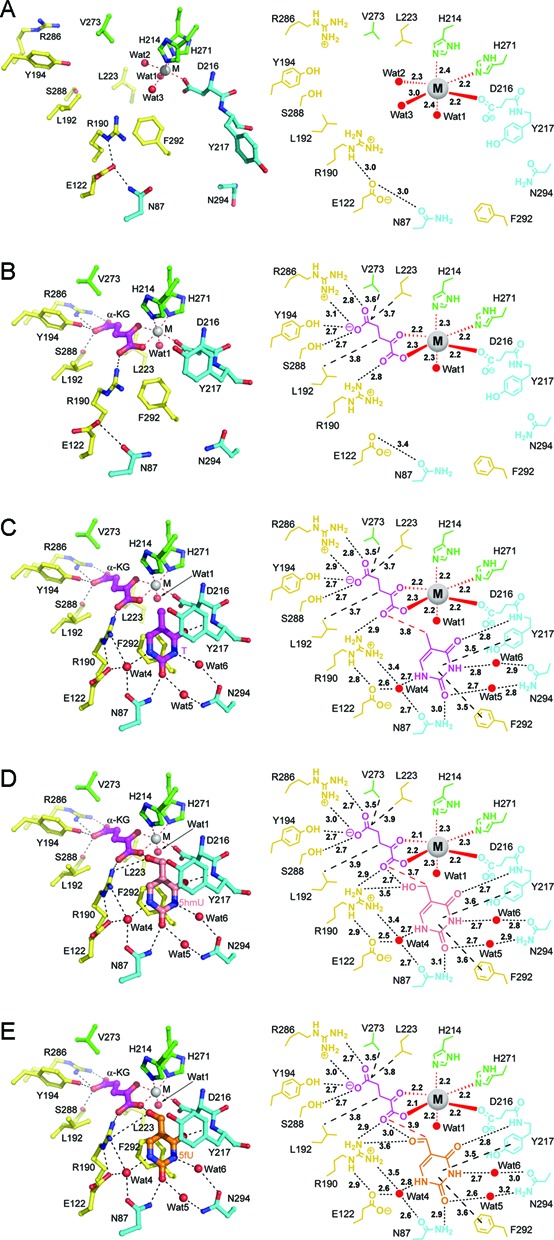
Structure (left panel) and schematic diagram (right panel) of the active site showing the interactions of the metal ion, α-KG and the substrate with the surrounding residues. (A) The apo NcT7HΔC. (B) The NcT7H-AKG complex. (C) The NcT7H-T complex. (D) The NcT7H-5hmU complex. (E) The NcT7H-5fU complex. The substrate, α-KG and the residues are shown with ball-and-stick models, the metal ion with a grey sphere, and the water molecules with red spheres. The colour coding for the residues is the same as in Figure 1A. The substrates T, 5hmU and 5fU are coloured in magenta, salmon and orange, respectively. The coordination bonds of the metal ion are shown with red dotted lines, the hydrogen bonds with black dotted lines, and the key hydrophobic interactions with black dashed lines. The bond lengths (Å) are indicated.